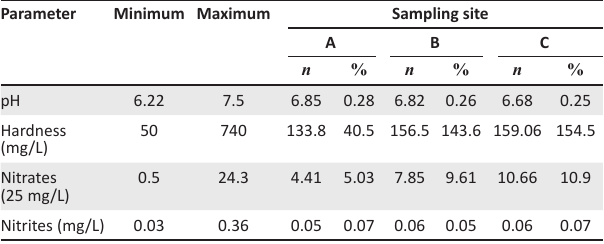
TABLE 1: Chemical and physical analysis of drinking water in 20 farms at three sampling sites: the water source (A), the beginning (B) and the end of the nipple line (C). The data are expressed as median values with standard deviation. Parameter Minimum